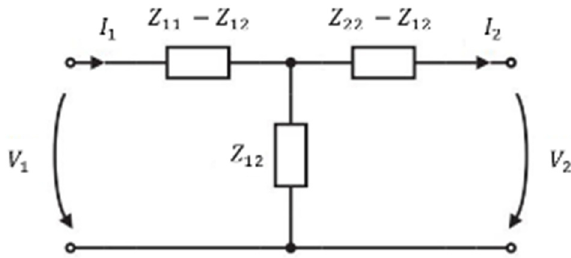
Figure 8. T-equivalent circuit